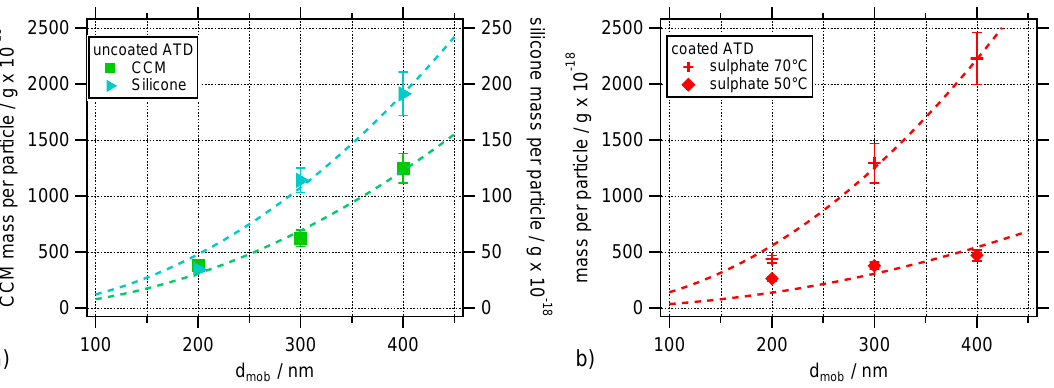
Fig. 3. Left: non-refractory mass per particle for uncoated ATD particles as a function of particle diameter. Vaporiser temperature: 600 ◦ C (FROST1). The quadratic fits forced through zero indicate that both CCM (carbon-containing material, left scale) and silicone (right scale) are contaminants on the surface of the ATD particles. Right: sulphate coating (50 ◦ C and 70 ◦ C coating bath temperature) as a function of particle diameter. The quadratic fit forced through zero indicates that the coating mass per particle is proportional to the particle surface for a coating temperature of 70 ◦ C.